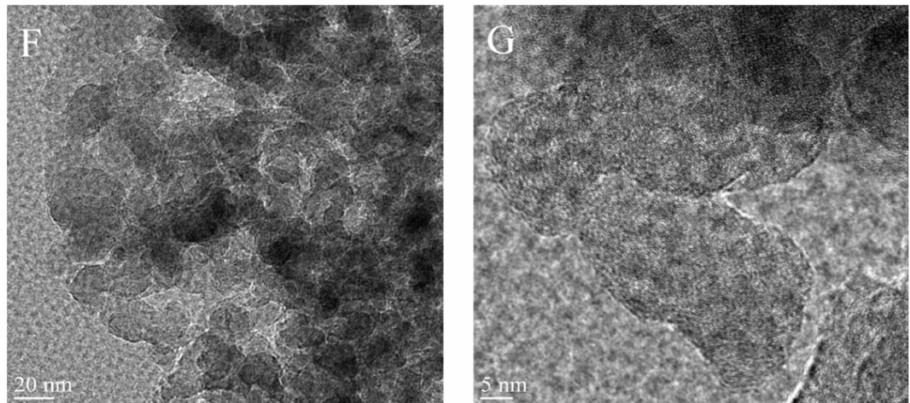
Figure 4. Scanning electron micrographs showing the morphology of ( A ) JIN-001 at 700 × magnifi- cation (Scale bar = 100 µ m); ( B ) CSD at 2000 × magnification (Scale bar = 20 µ m); ( C ) JLS at 2000 × magnification (Scale bar = 20 µ m); ( D ) CSD at 25,000 × magnification (Scale bar = 2 µ m); ( E ) JLS at 25,000 × magnification (Scale bar = 2 µ m). Transmittance electron microscopy (TEM) micrographs showing the morphology of ( F ) JLS at 105,000 × magnification (Scale bar = 20 nm); ( G ) JLS at 290,000 × magnification (Scale bar = 5 nm).